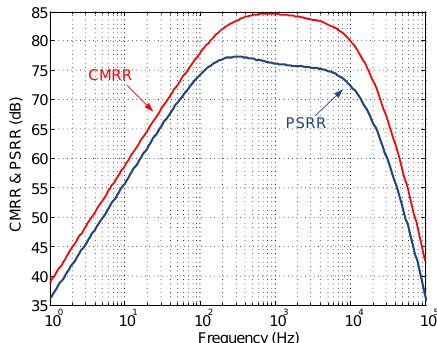
Figure 15. Measured LNA CMRR and PSRR.